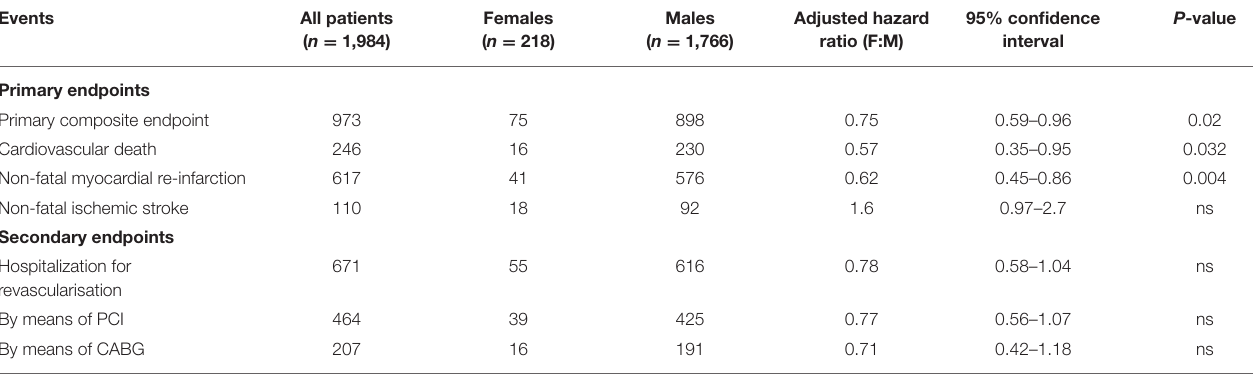
TABLE 3 | Total occurrence of primary and secondary endpoints during follow-up by sex.